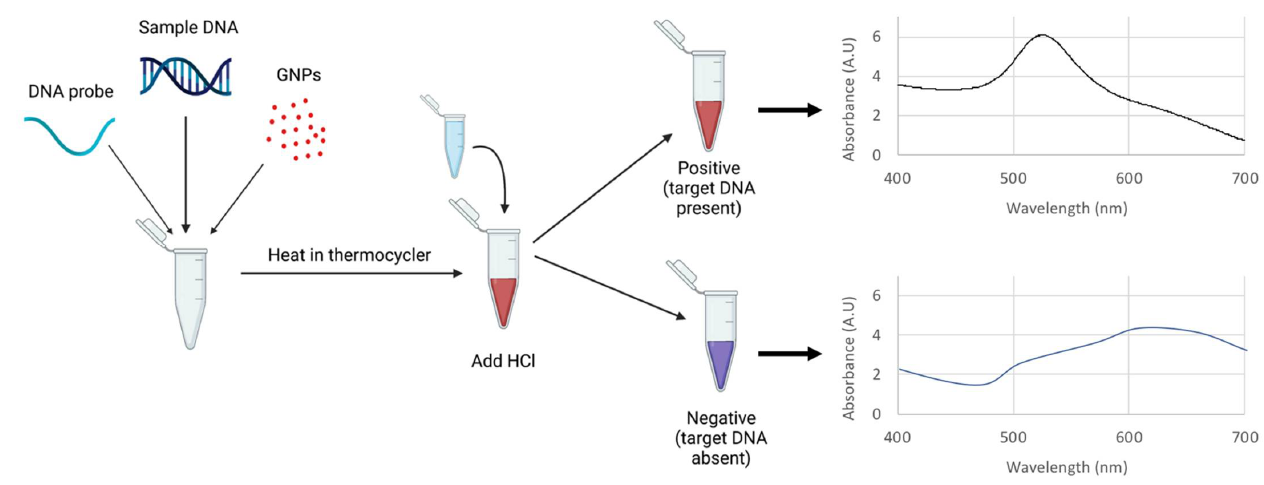
Figure 2. Basic procedure for GNP biosensor.